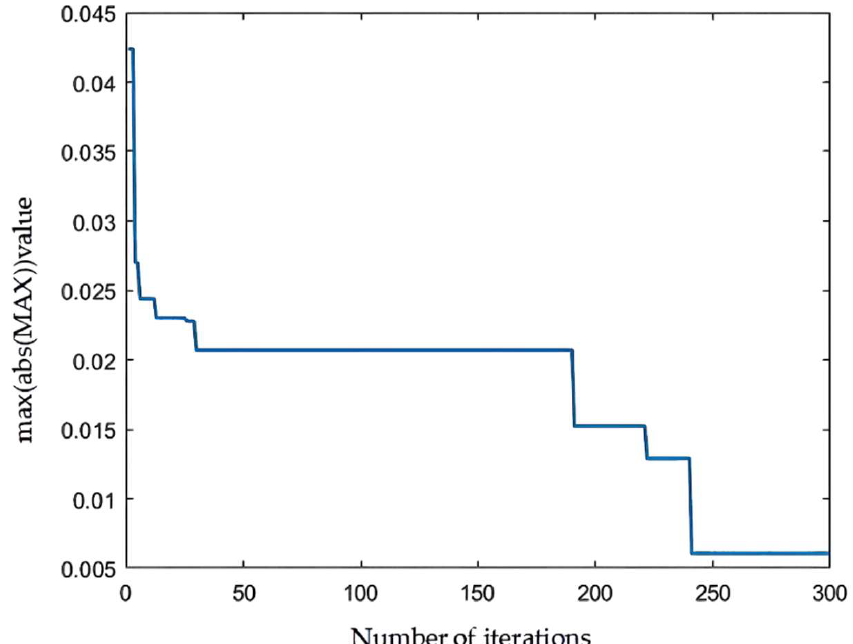
Figure 8. Trend of the value of the fitness function of the bridge deck measurement points based on the IPSOARW.